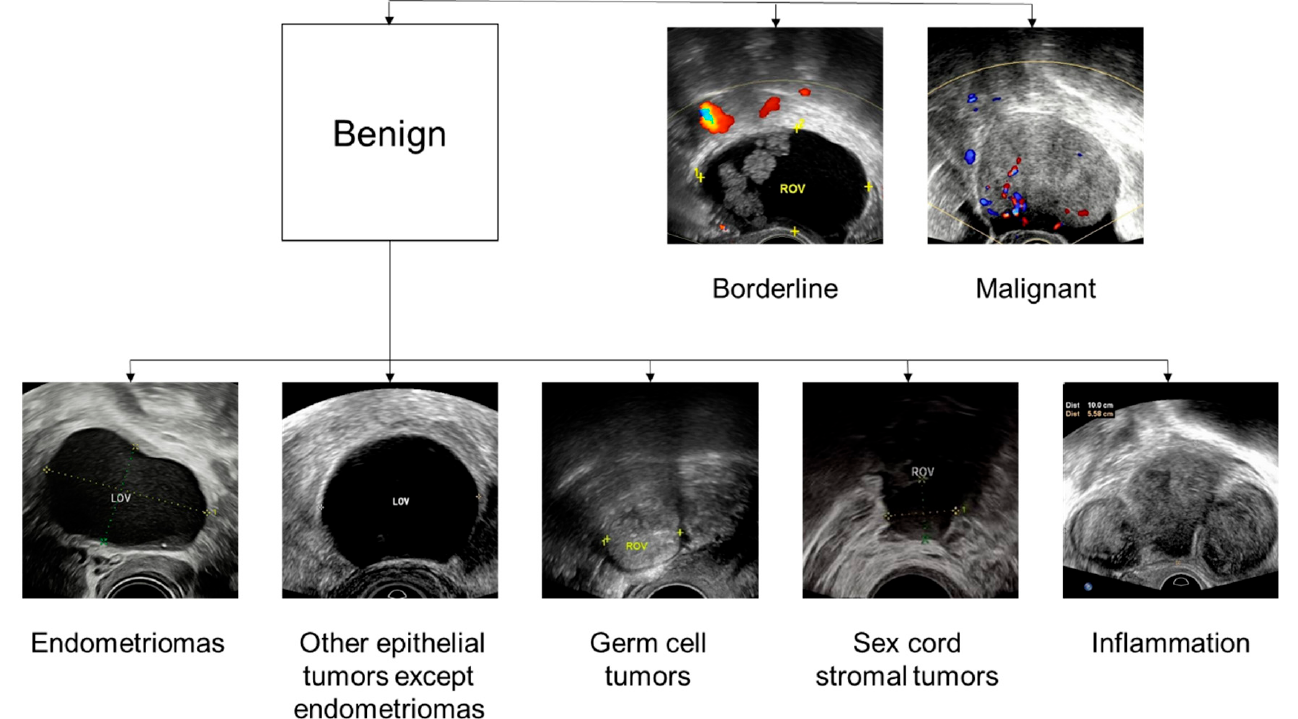
Figure 6. Example ultrasound images of different types of adnexal masses and different pathological subtypes of benign tumors.